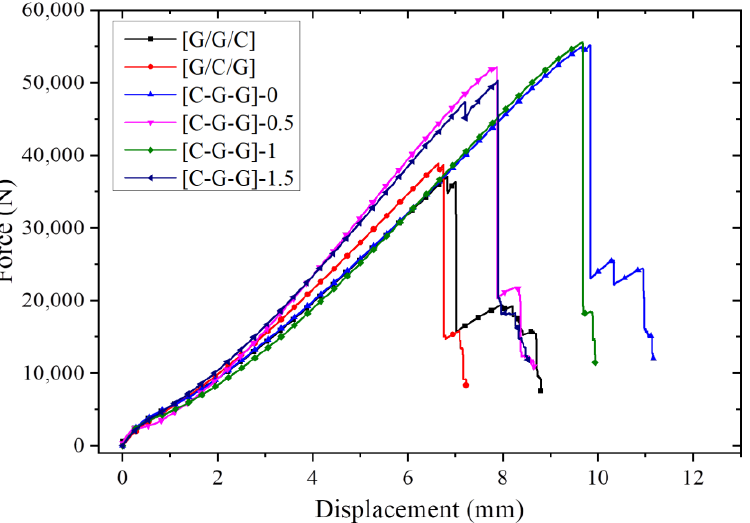
Figure 8. Tensile force–displacement curves of intralayer hybrid composites with the hybrid ratio C:G = 1:2.